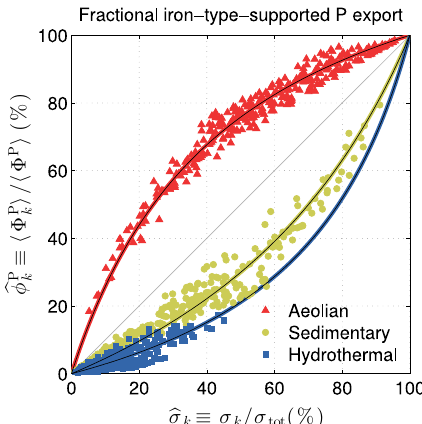
Figure 8. Percent global phosphorus export (equivalently carbon export) supported by each iron type (aeolian, sedimentary, hy- drothermal) versus the corresponding fractional source of that iron type. The superposed lines are least-squares fits to theoretical re- lationships with fixed relative export-support efficiencies. (See text for